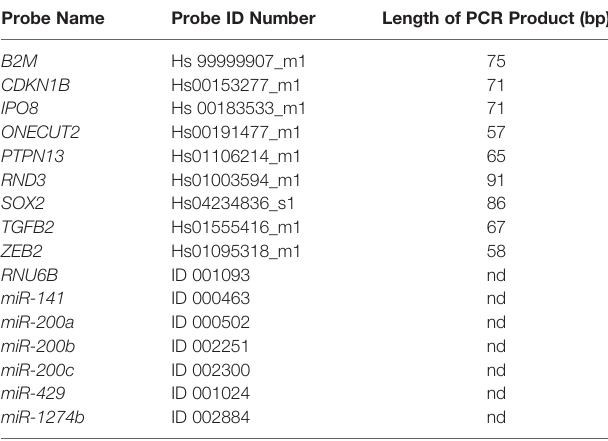
TABLE 1 | Probes used for miRNAs and mRNAs quanti fi cation using quantitative real-time PCR